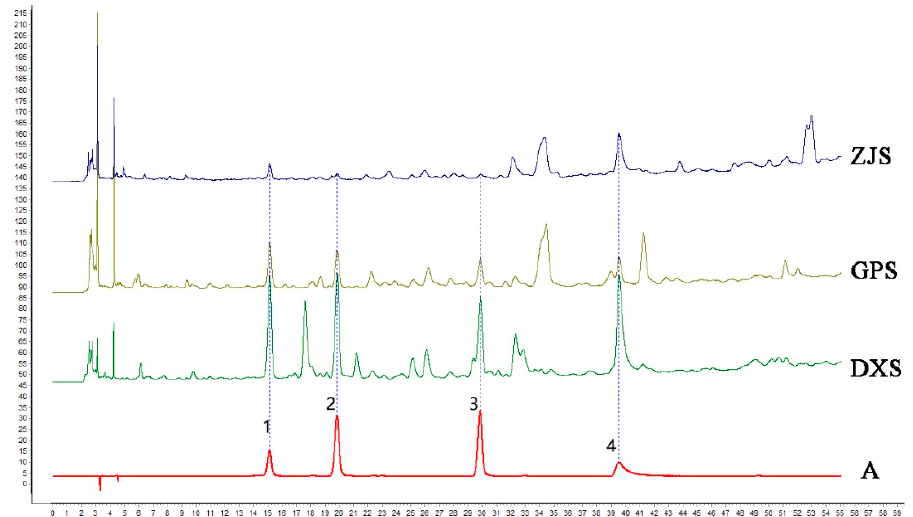
Figure 10. Qualitative analysis in the extracts of D. officinale : A represents the HPLC chromatogram of the four standards (1. Vicenin II; 2. Vicenin I; 3. Vicenin III; 4. Rutin.). DXS, GPS and ZJS represent RS samples, GP samples and ZJ samples, respectively.